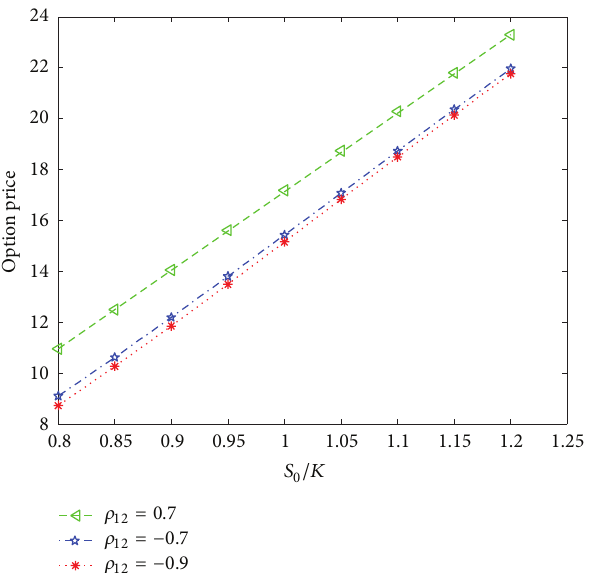
Figure 3: The option price with different correlation coefficients 𝜌 12 for 𝑇 = 1 , 𝜔 = 0.4 , 𝜌 13 = 0.5 , and 𝜌 23 = 0.6 .